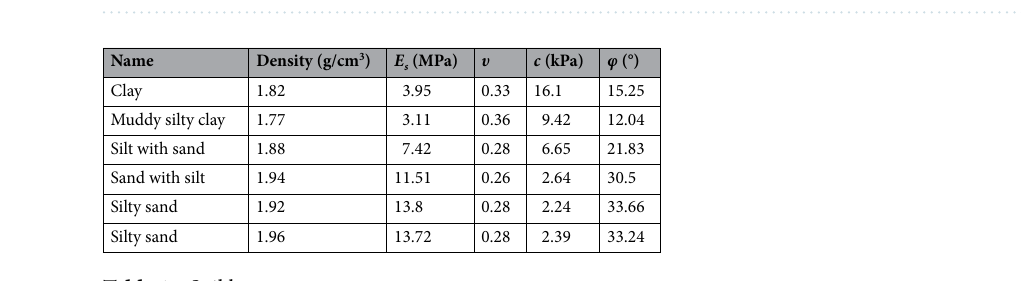
Figure 3. Excavation profiles of sections NMW01–NMW11. ( a ) Excavation profiles of sections NMW01– NMW07. ( b ) Excavation profiles of sections NMW08–NMW11.